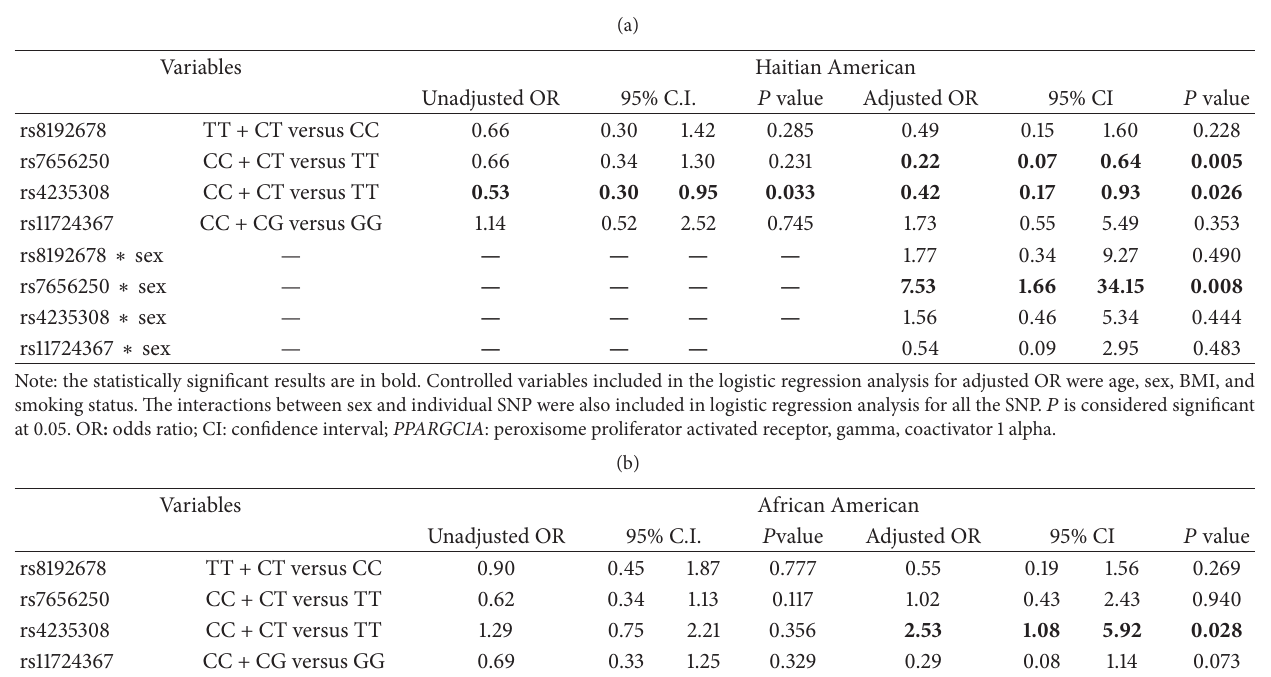
Table 4: (a) PPARGC1A SNP association with T2D in Haitian Americans. (b) PPARGC1A SNP association with T2D in African Americans.